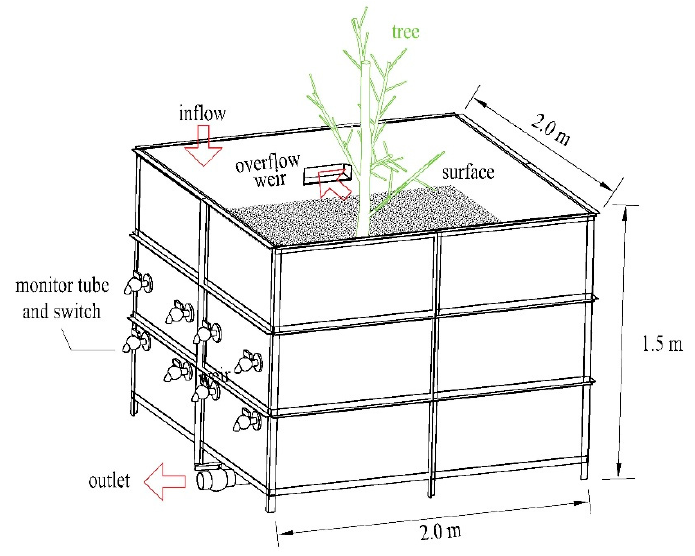
Figure 1. Schematic of the test setup.